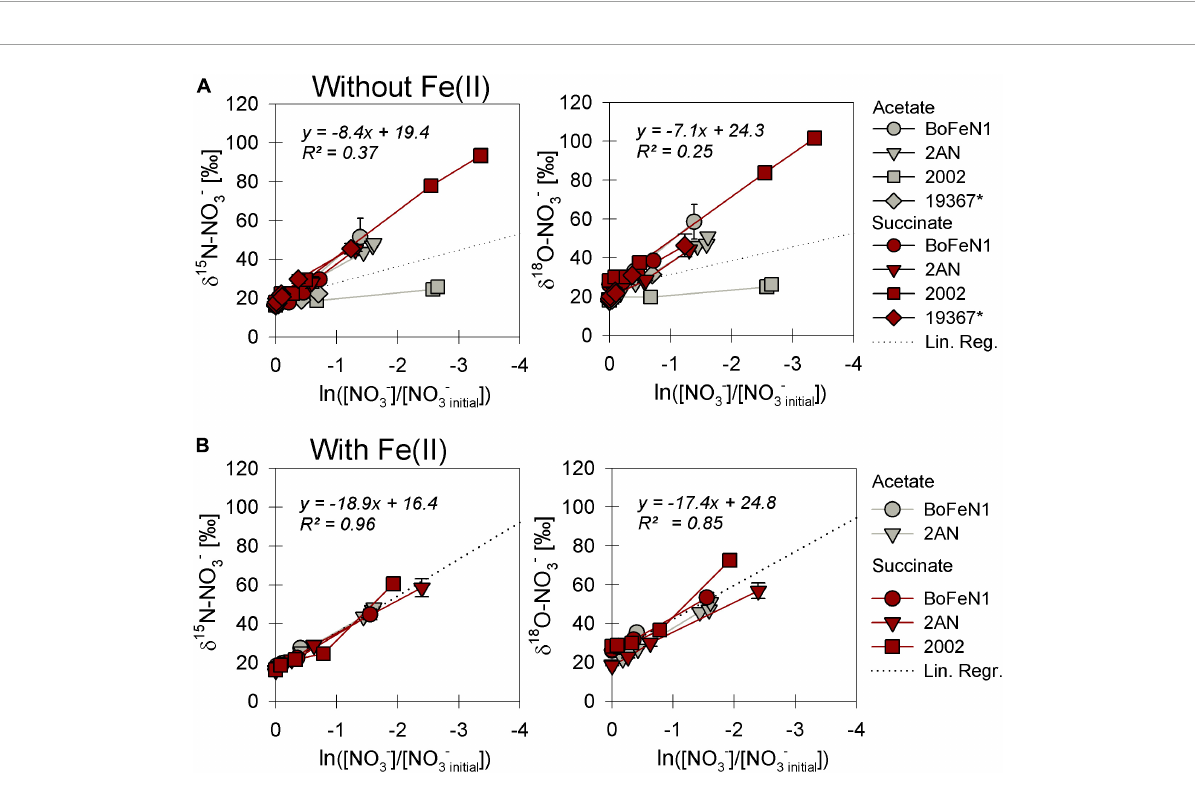
FIGURE3 Rayleigh plots of δ 15 N and δ 18 O-NO 3 − for strains grown under heterotrophic (A) and mixotrophic (B) conditions. The denitrifier control Paracoccus denitrificans ATCC 19367 (*) did not grow in the presence of Fe(II) and is not represented in panel (B) . Linear regression lines, the slope of which approximate the N and O isotope effects ε for nitrate reduction (Eq. 4), are calculated including all data in plot. Error bars represent standard error calculated from biological replicates (see Table 2